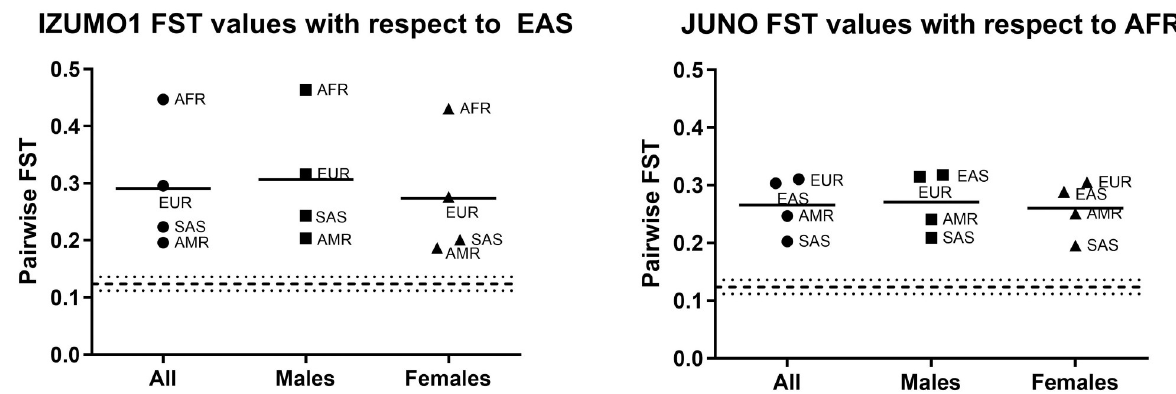
Fig 6. F ST values for the IZUMO1 gene with respect to the East Asian (EAS) and for the JUNO genes with respect to the African (AFR) populations. Each population group is analyzed in its entirety as well as for each sex. These F ST values were calculated using SNPs with a MAF of at least 5%. An F ST along the 0.124 value (dashed line plus or minus dotted lines) is considered to be consistent with whole human genome [57]. The average F ST value (solid line) for each sex is consistent with the average F ST value for both sexes combined. The populations analyzed include AMR (n = 347), AFR (n = 661), EUR (n = 503), EAS (n = 504), and SAS (n = 489), where n indicates the number of individuals in each population group.